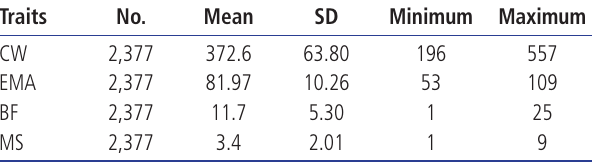
Table 3. Basic statistics of traits